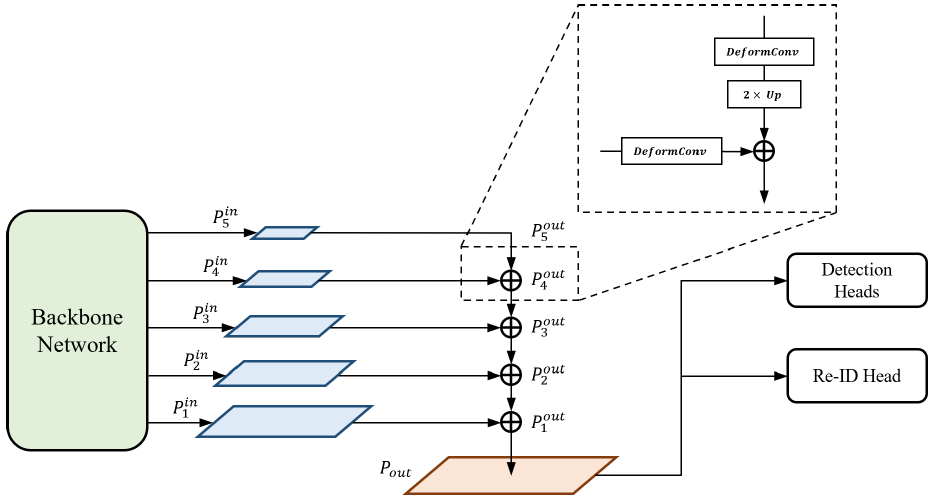
Figure 3. Output-feature fusion network architecture of our proposed